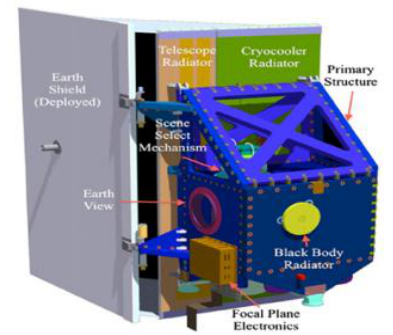
Figure 6. Configuration of TIRS (D.P.Roy, 2014a) 2.2.2. Nimbus-7 satellite /TOMS: Nimbus-7 satellite